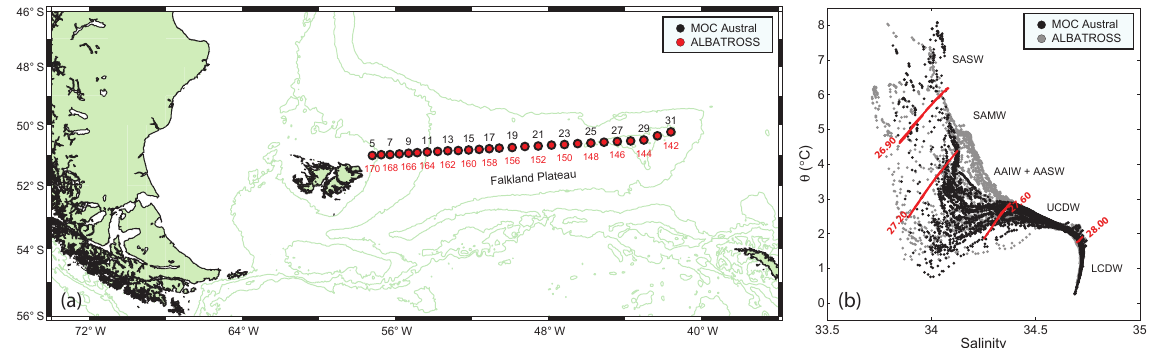
Figure 1. (a) Hydrographic stations across the Falkland Plateau carried out during the ALBATROSS (1999, red station numbers) and MOC- Austral (2010, black station numbers) cruises. (b) θ − S diagram for both cruises. Red solid lines represent the γ n values (26.90, 27.20, 27.60 and 28.00kgm − 3 ) defining the different water masses in the